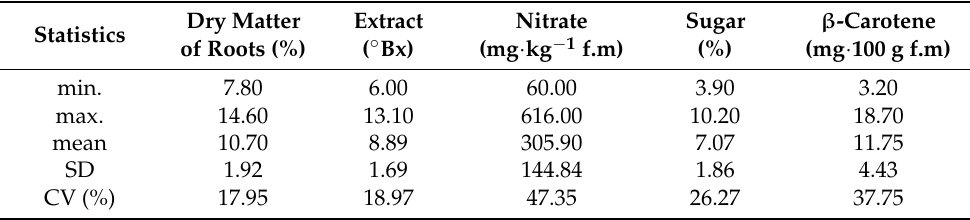
Table 9. The content of dry matter, extract, nitrate, sugar, and β -carotene in the roots of Daucus carota subsp. sativus growing in 21 allotment plots of Gorz ó w Wielkopolski.